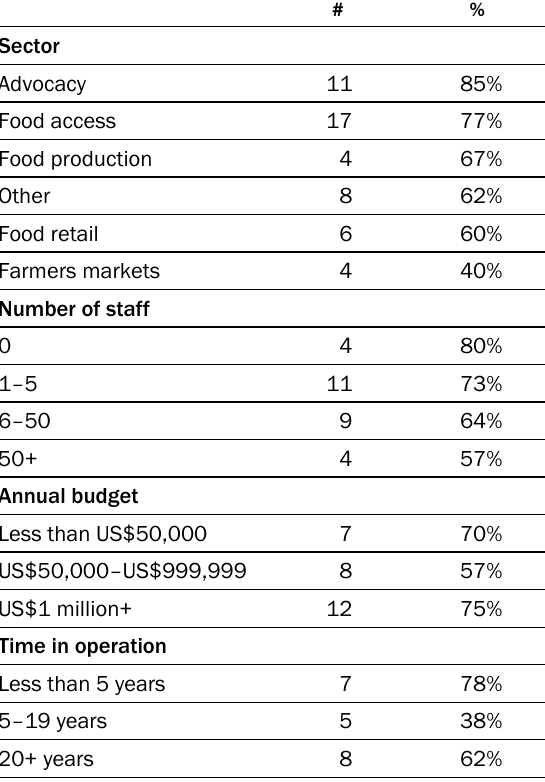
Table 6. Survey Respondents Partnering with Other Organizations or